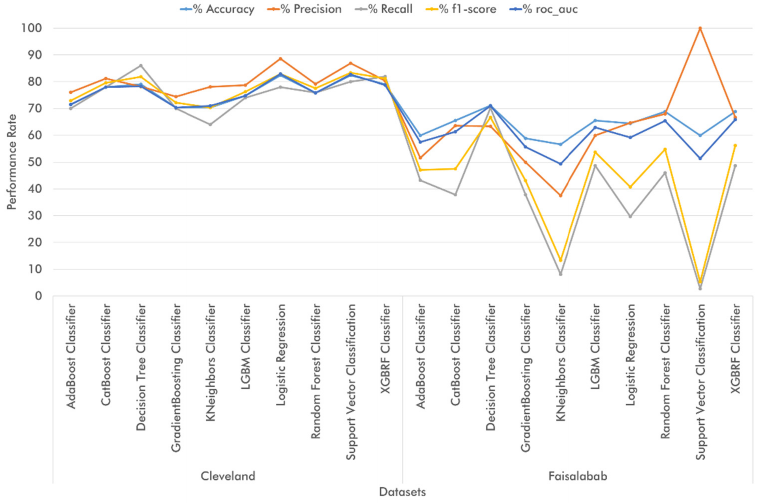
Figure 4. Train-test dataset performance of ten LM classifiers on the top-four attributes from the Cleveland and Faisalabad attributes.